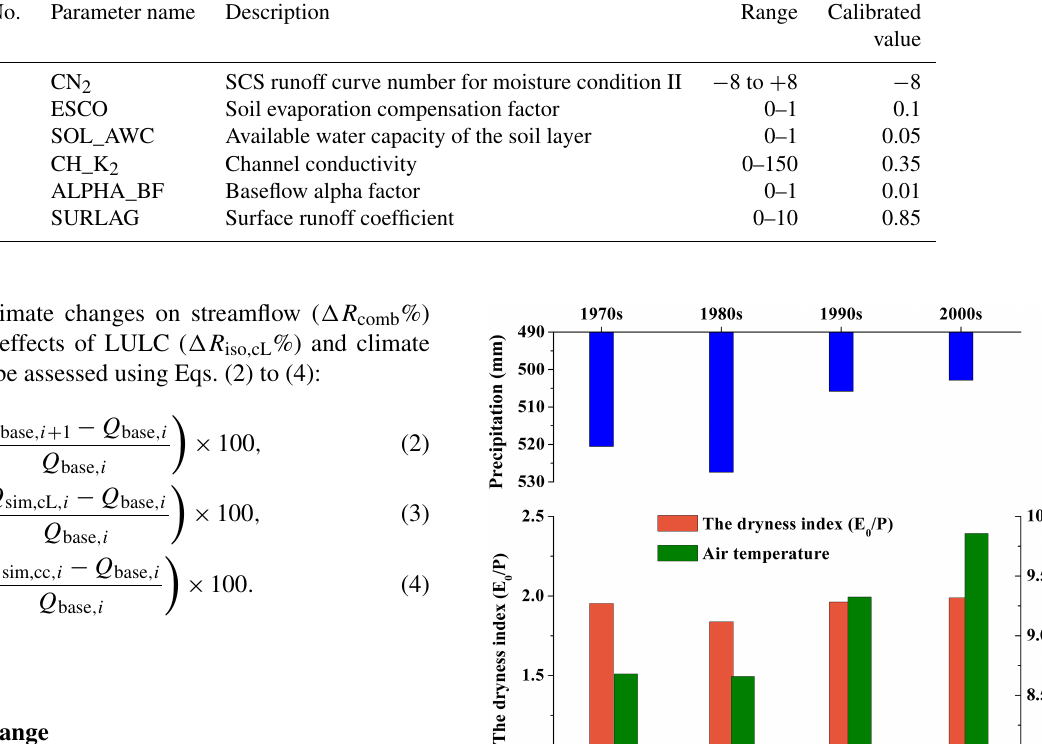
Table 1. Calibrated values of the six parameters in SWAT. No.